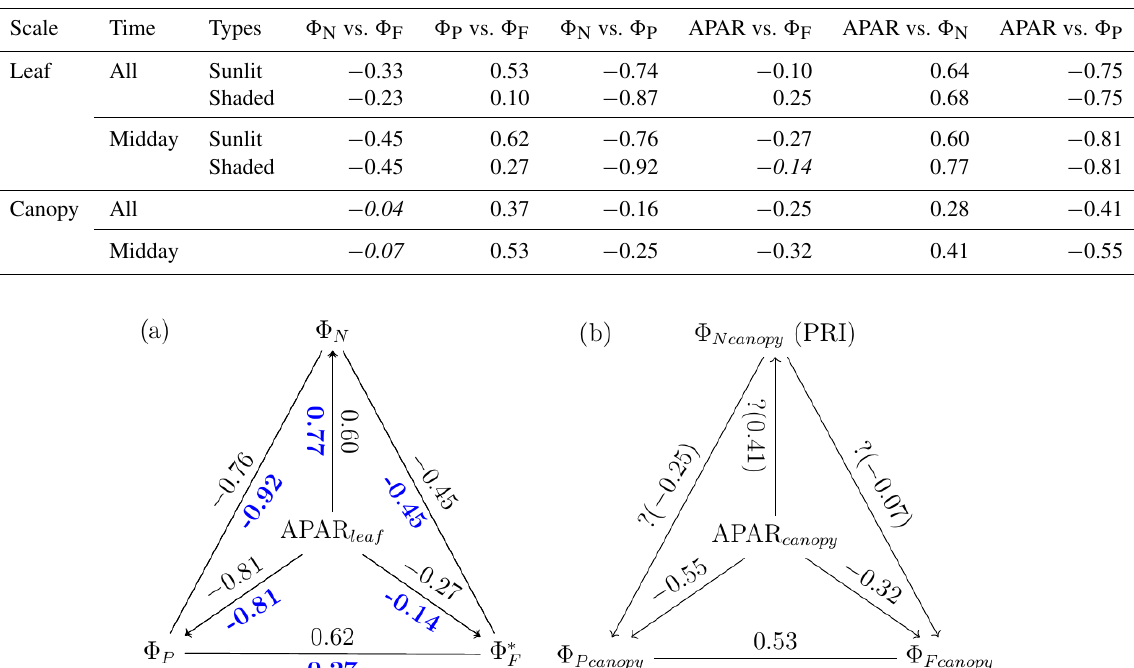
Table 3. Correlations between variables describing energy partitioning at leaf and canopy scales. The coefficients are placed in italics if the relationship is not significant ( p value > 0.10).